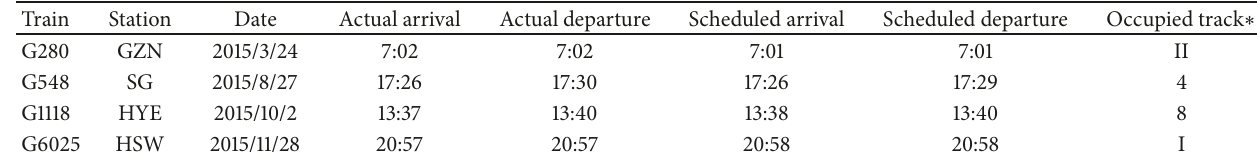
Table 1: Train operation data format in database.